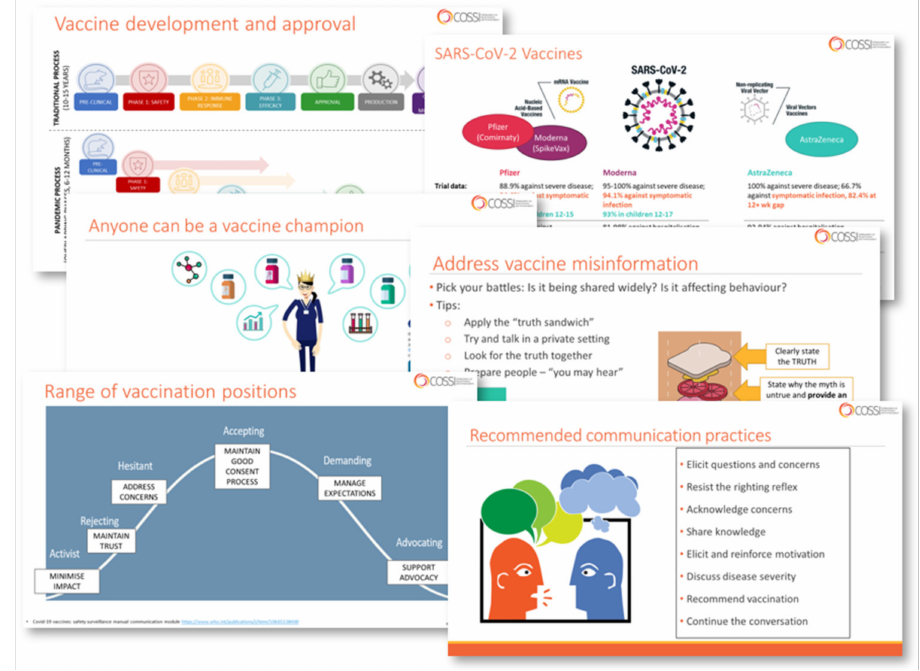
Figure 1. Sample slides from Vaccine Champions training